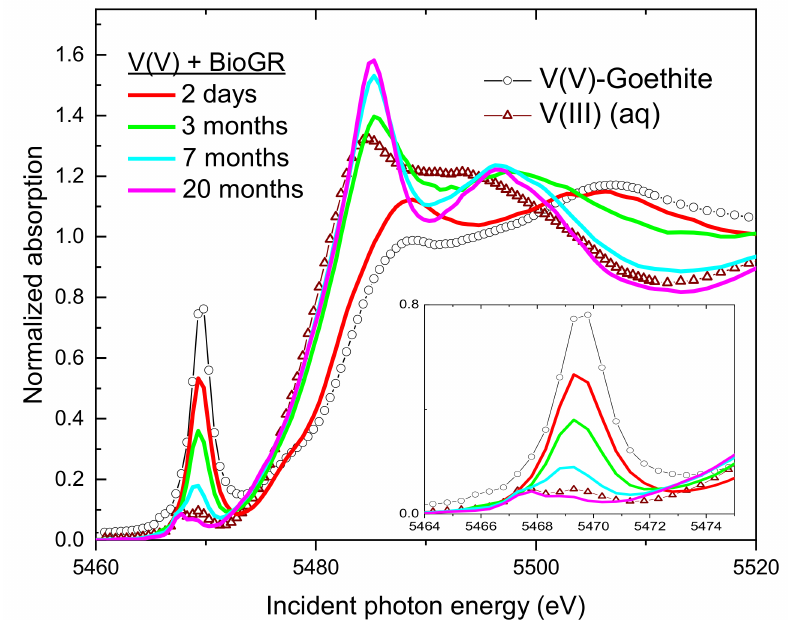
Figure 8. The V K-edge XANES spectra of the solids in the biogenic green rust (BioGR) system over time compared to representative standards V(V) sorbed to goethite and aqueous V(III). Inset shows details in the pre-edge region.